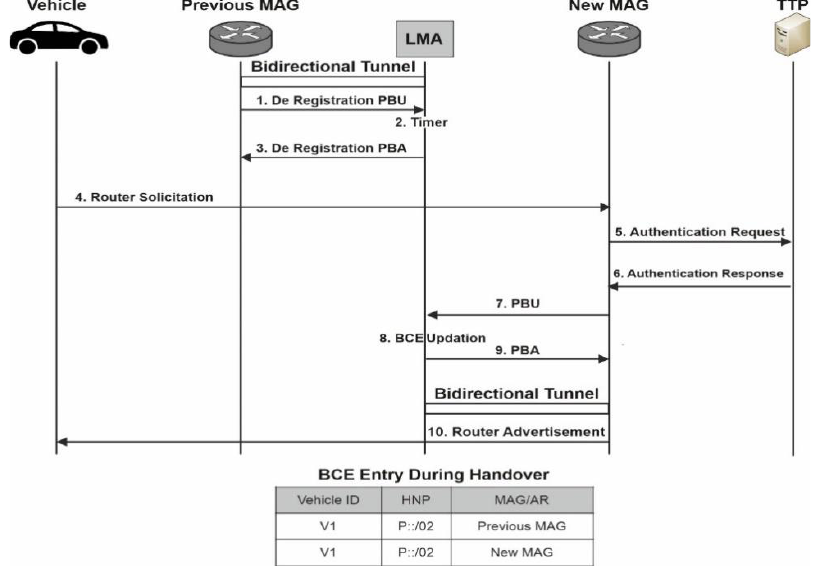
Figure 5. Handover of Vehicle in PMIPv6.